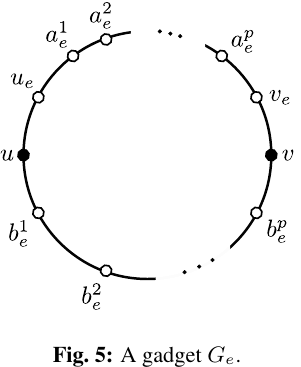
Fig. 5: A gadget G e